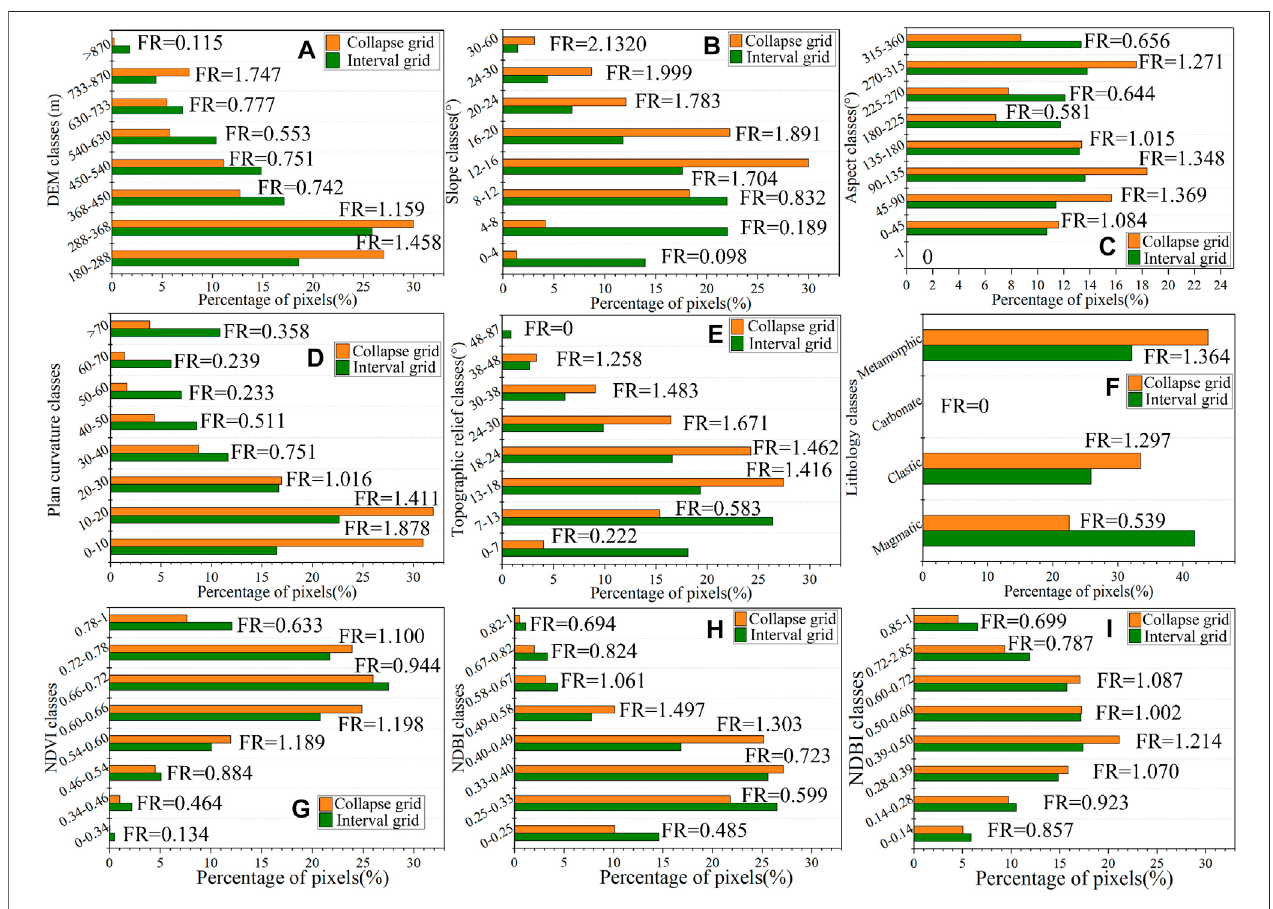
TABLE 1 | Collinearity test results of collapse environmental